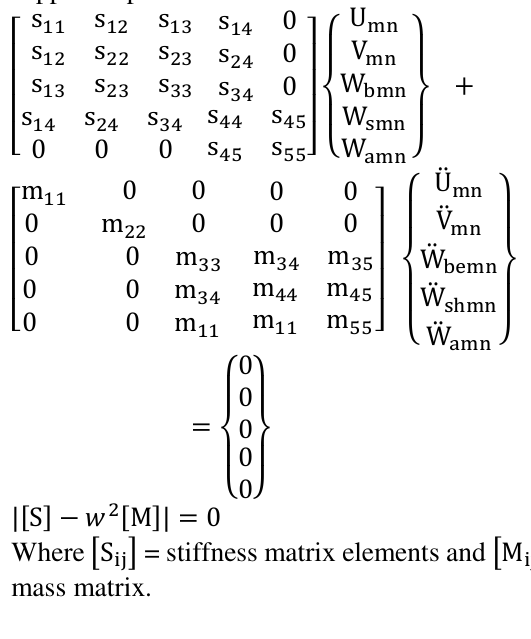
Developing mass matrix and stiffness matrix from solution of homogeneous equations, when mechanical loading is equal to zero for free vibration, then eigenvalue equation is derived and the natural frequencies of vibration for simply supported plate are